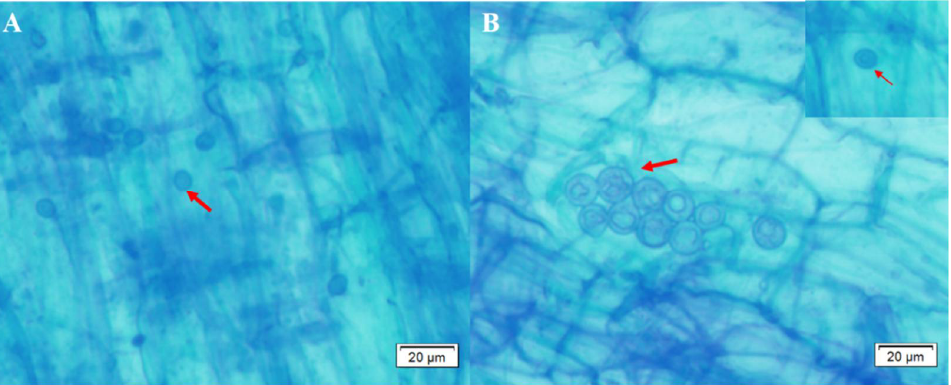
Figure 1. Trypan blue staining result for the observation of the S. indica colonization in roots of ‘Zhongjiao No. 3’ ( A ) and ‘Zhongjiao No.4’ ( B ) banana seedlings. Red arrows represent typical S. indica spores observed in banana roots.